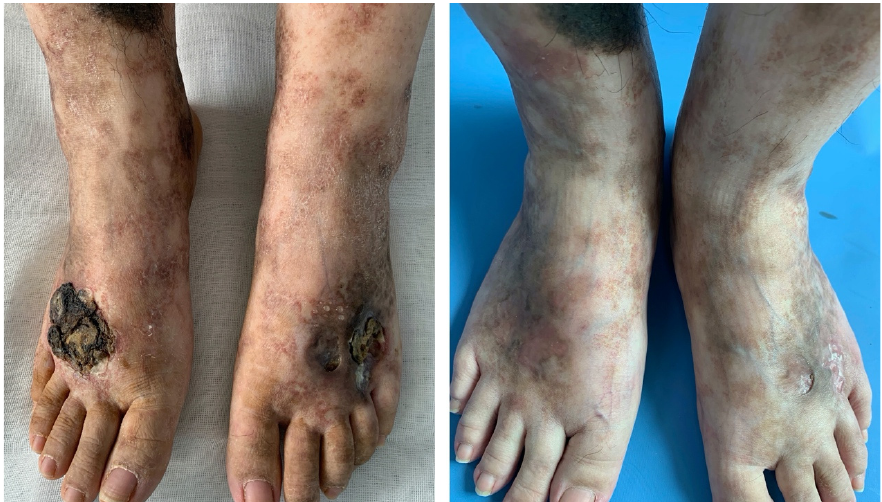
Figure 1. Clinical images of patient 1 before and 4 months after adalimumab treatment.